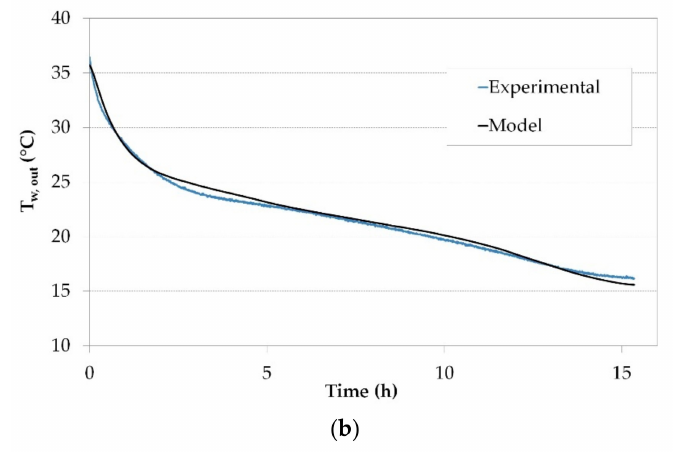
. V = 1.20 m 3 · h − 1 ) and for ( b ) a